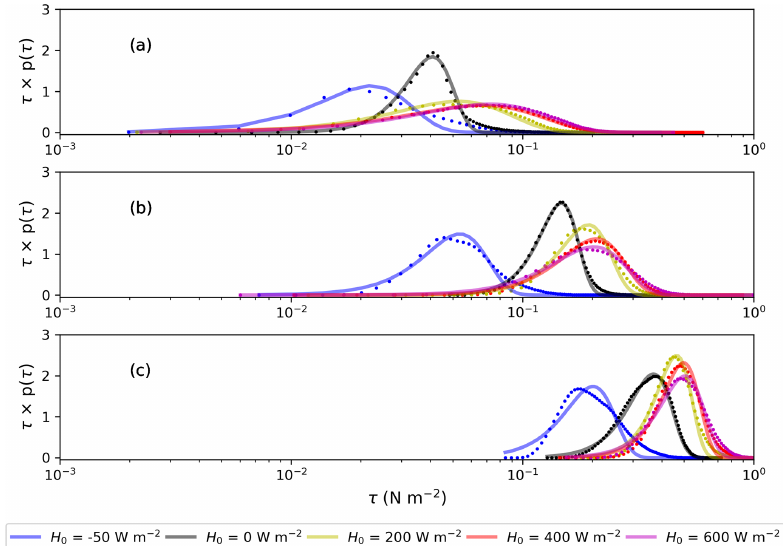
Figure A1. Probability distributions of simulated surface shear stress τ (dots) and the corresponding fitted Weibull density distribution (solid lines) with different surface heat flux for different wind conditions: (a) U = 5 . 44ms − 1 , (b) U = 10 . 87ms − 1 , and (c) U = 18 . 12ms − 1 .